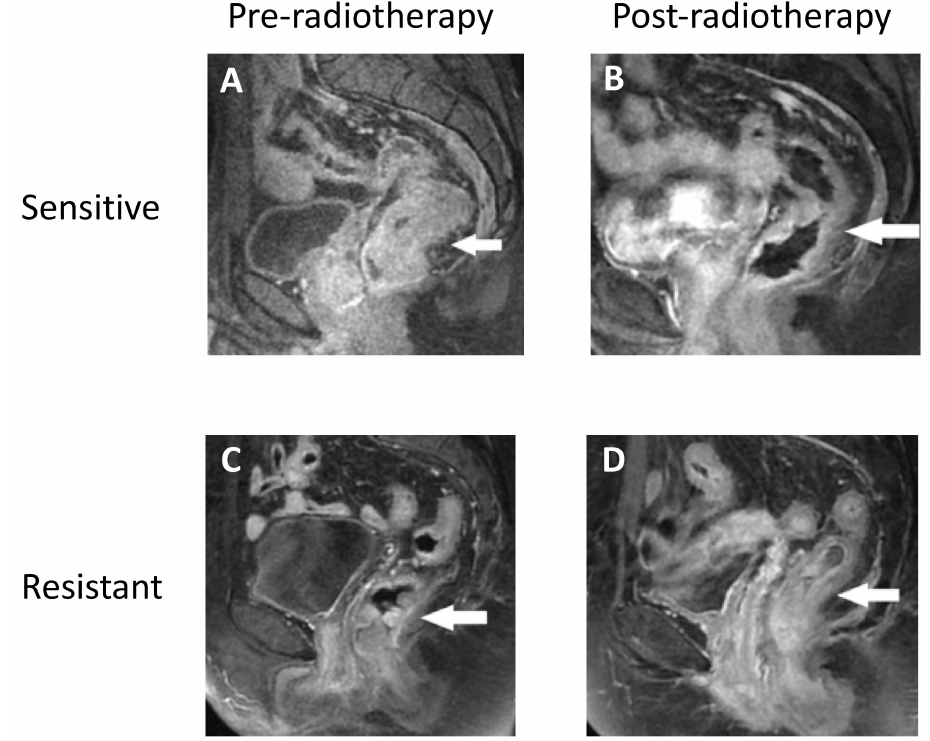
Figure 4. In vitro treatment predicted the clinical outcomes of rectal cancer patients treated with neo-adjuvant radiation. Representative MRI images before ( A ) and after ( B ) the radiotherapy of a patient whose CSCs became sensitive to in vitro treatment. Representative MRI images before ( C ) and after ( D ) radiotherapy of a patient whose CSCs became resistant to in vitro